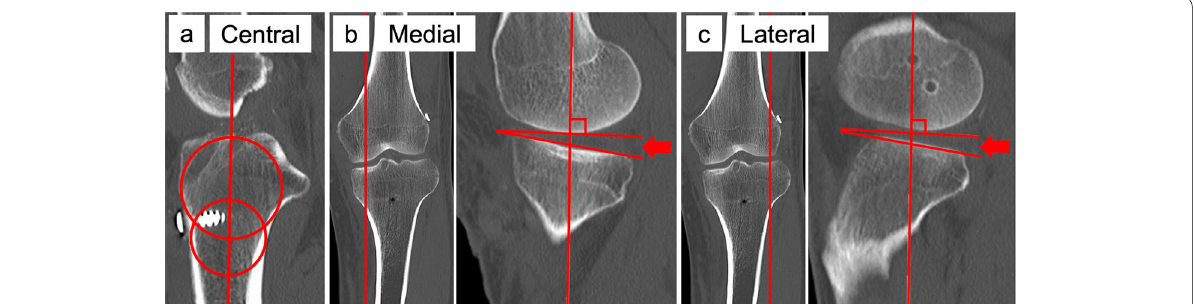
Fig. 2 Posterior tibial slope (PTS) measurements using CT images. The arrow indicates the angle of lateral and medial